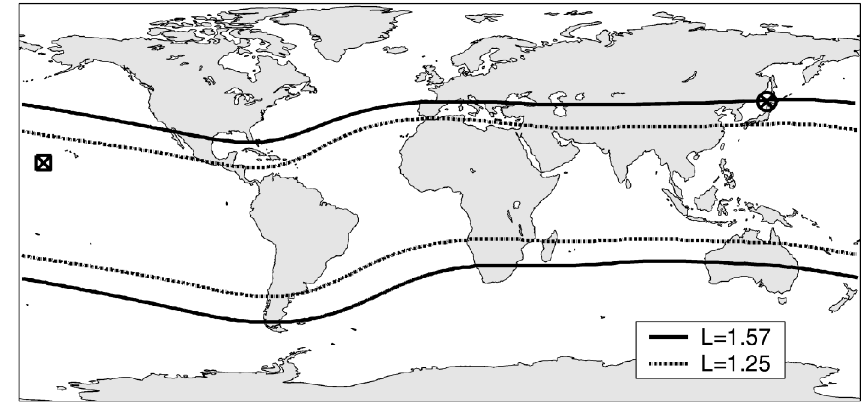
Fig. 1. Map showing the important locations in our study. The original Starfish Prime HANE occurred above Johnston Island (square), while our SIC modelling points are above the city of Sapporo (circle at L =1.57). The 100km footprints of the IGRF determined L =1.25 and L =1.57 are also